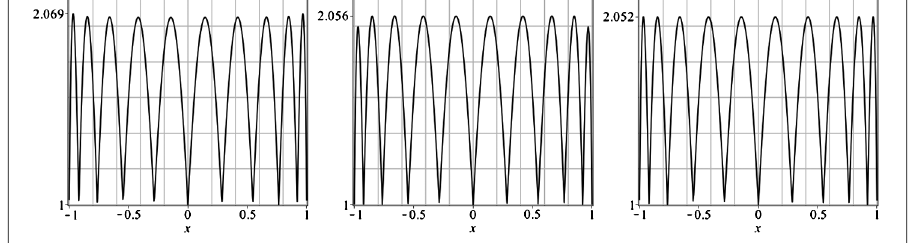
Figure 4 Graphs of L 10 ( ˆ T ; x ), L 10 ( ˘ T ; x ), L 10 ( X ∗ ; x ) from left to right.